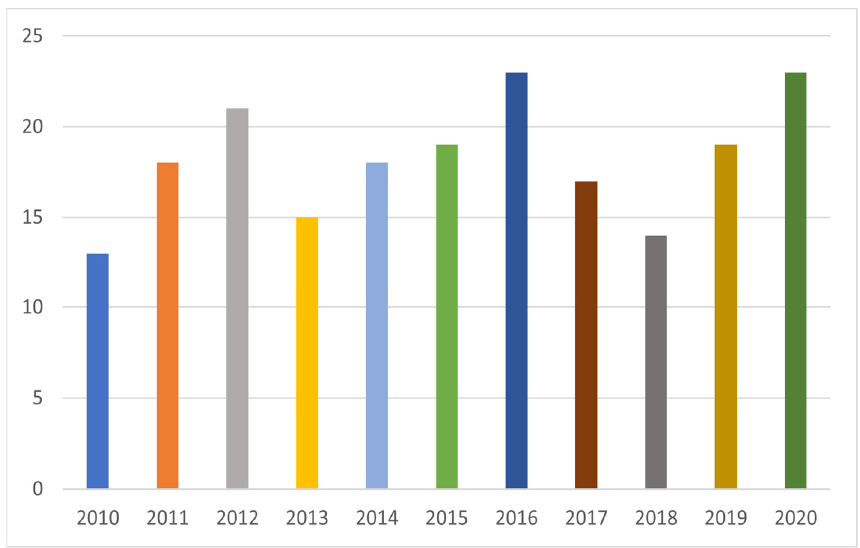
Figure 2. Selection of research articles per year.